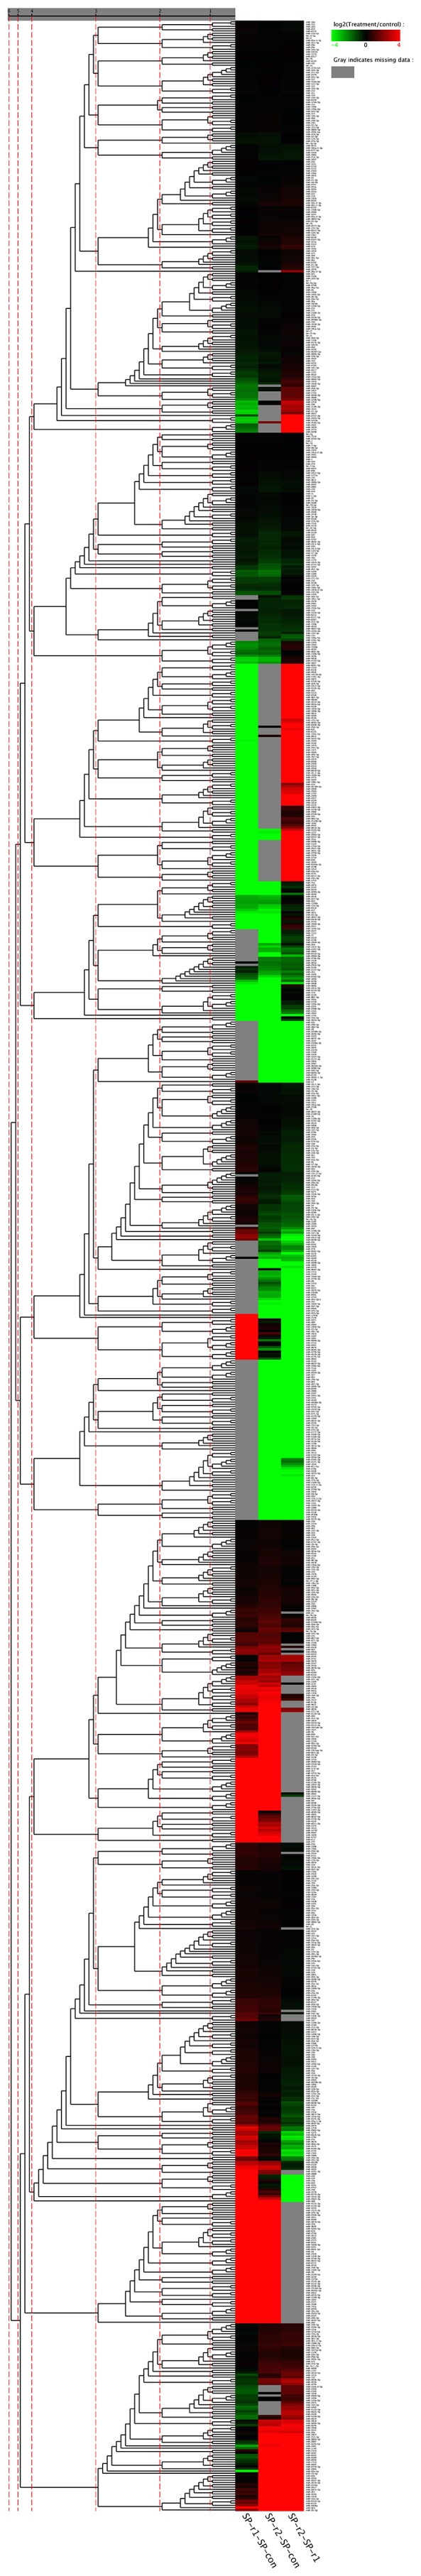
Expression of the identified miRNAs in the three different samples using hierarchical clustering.Highly expressed miRNAs are indicated in red, and miRNAs with low expression are indicated in green; grey indicates missing data. The absolute signal intensity ranged from −4.0 to +4.0.